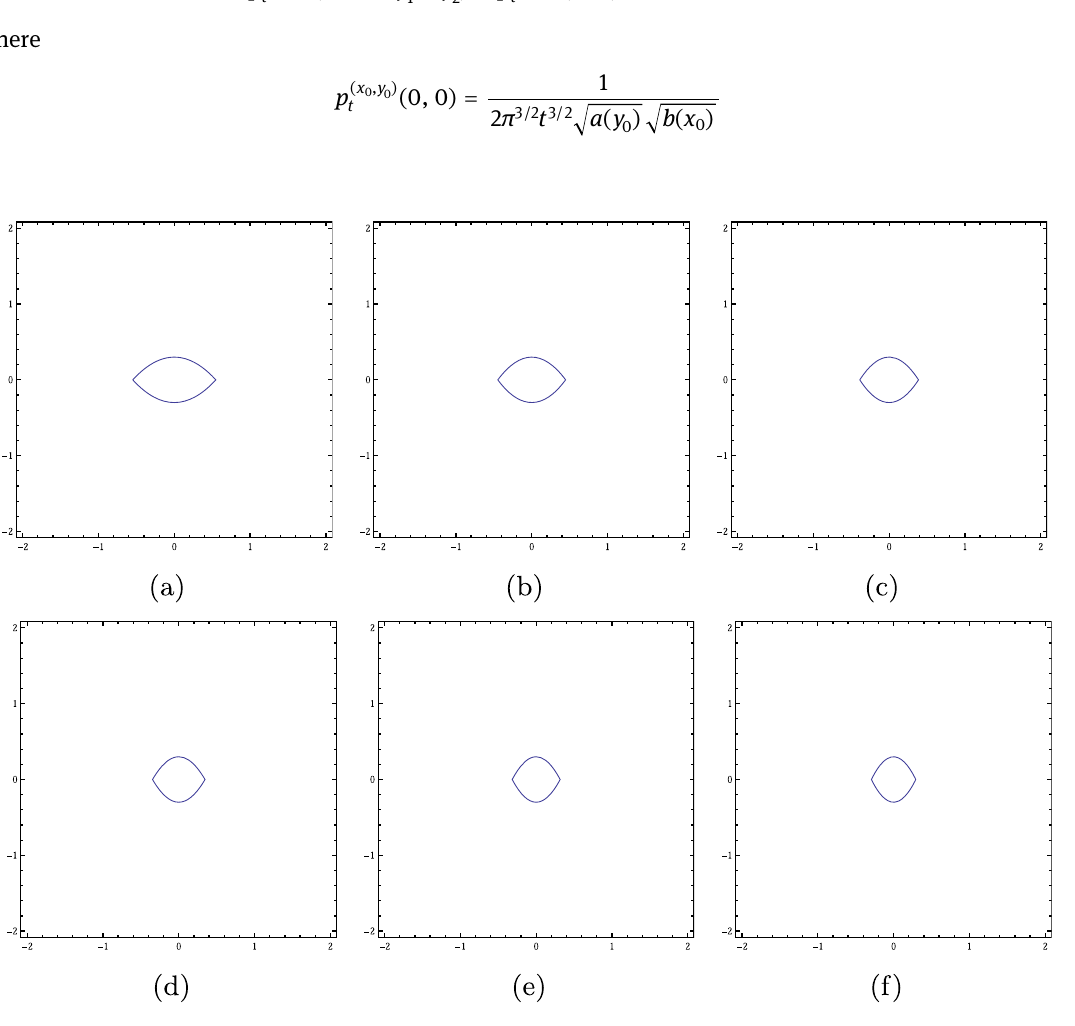
Figure 2: The shape of metric ball ( ) B 0 tψ when we fi x = t 0.3 , = b 1 and a takes the values from 1 to 3.5 in the interval of 0.5.